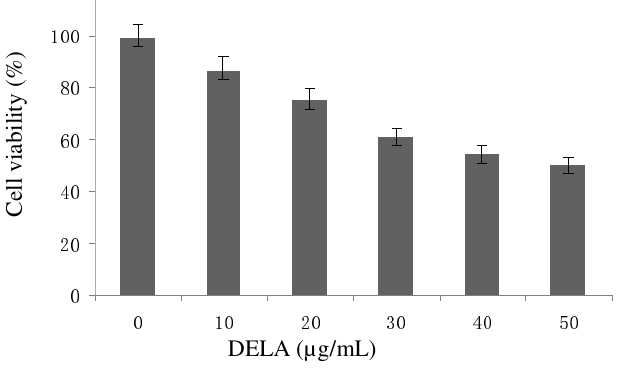
Figure 1. Comparison of the inhibitory effects of DELA on murine sarcoma S180 cells. Data are shown as mean ± SD (n = 3).